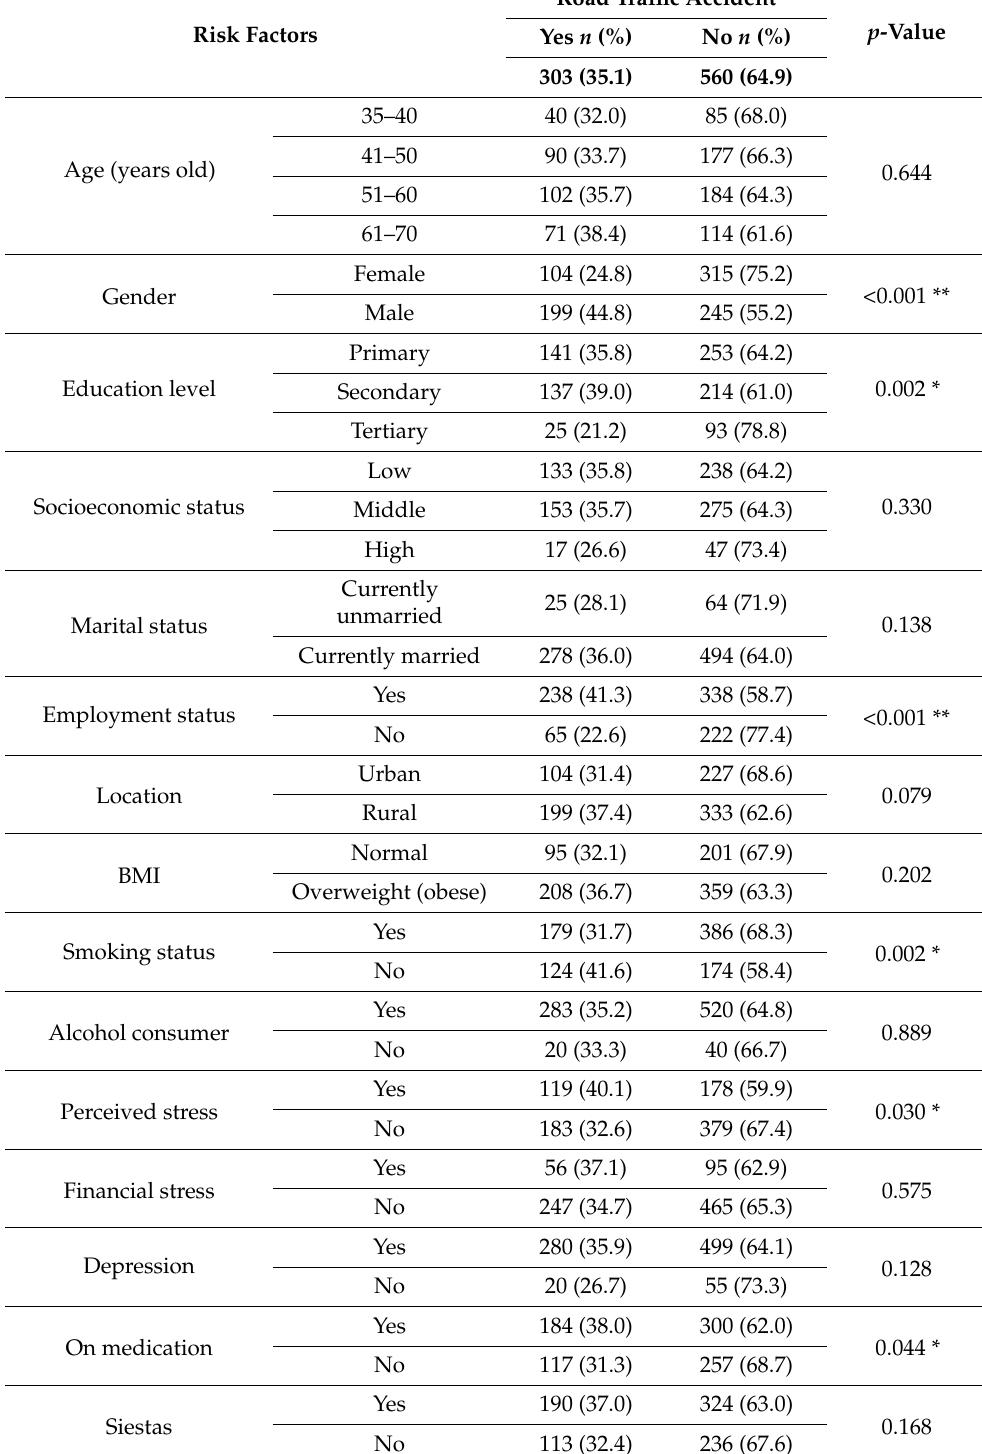
Table 1. General characteristics of study participants ( n =